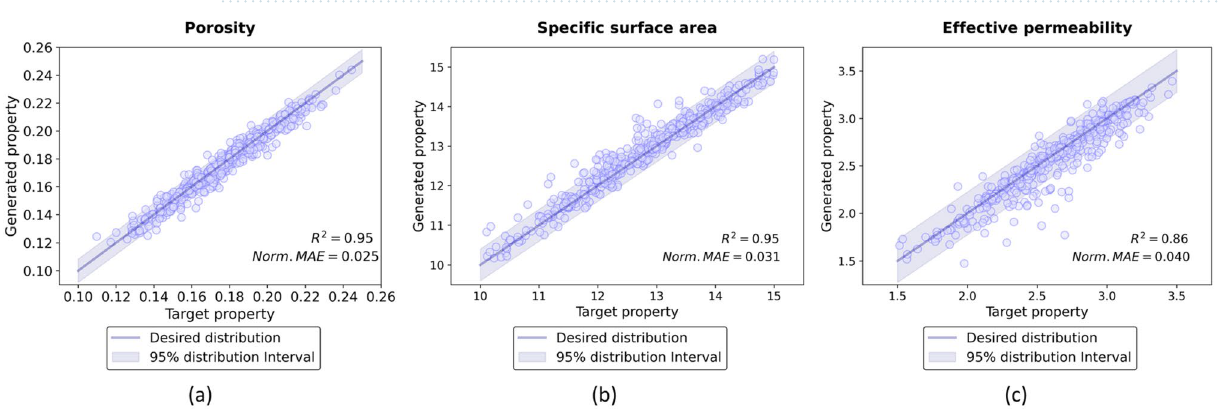
Figure 7. Visualization of synthetic microstructures generated by the proposed GAN-AC framework (top) and their corresponding targeted microstructures (bottom). The 3D voxelized data has been made available to public for inspection and third-party validation.